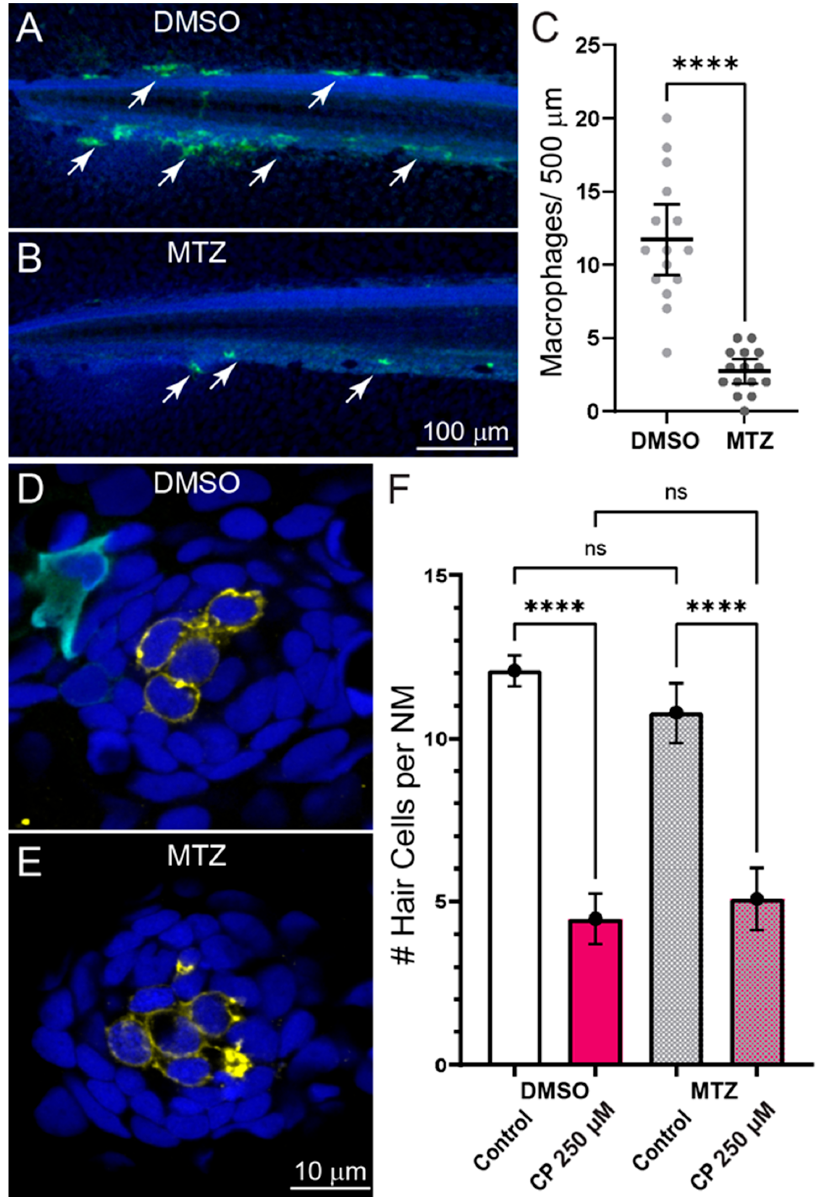
Figure 3. Depleting macrophages does not affect cisplatin induced neuromast hair cell loss. ( A – C ) Selective depletion of macrophages in double transgenic fish (gl25Tg, Tg(mpeg1.1:GAL4FF ); c264Tg, Tg(UAS-E1B:NTR-mCherry ). ( A , B ) Representative images of macrophage distribution (indicated with arrows) within the posterior-most 500 µm of the spinal column of fish treated with for 24 h with 0.1% DMSO ( A ) or 10 mM MTZ ( B ). ( C ) MTZ-treated fish showed a significant depletion of macrophages relative to DMSO-treated control (Unpaired t -test; **** p < 0.0001). Bars = Mean w/95% CI. Data obtained from 16 fish/treatment group. ( D , E ) Single z-section images taken from confocal stacks of neuromasts in fish following treatment with 250 µM cisplatin. Macrophages are labeled with YFP (cyan), hair cells with an antibody to Otoferlin (HCS-1; yellow) and all cell nuclei are labeled with DAPI (blue). ( F ) Quantification of hair cell loss following exposure to 250 µM cisplatin and 24 h recovery. Significant hair cell loss following cisplatin was observed in both DMSO and MTZ treatment groups relative to controls (Tukey’s multiple comparisons test, **** adjusted p < 0.0001), but no difference in cisplatin-induced hair cell loss was observed between DMSO and MTX treatment groups (adjusted p = 0.6415) Bars = Mean w/95% CI. n = 37–39 fish per treatment group, N = 3